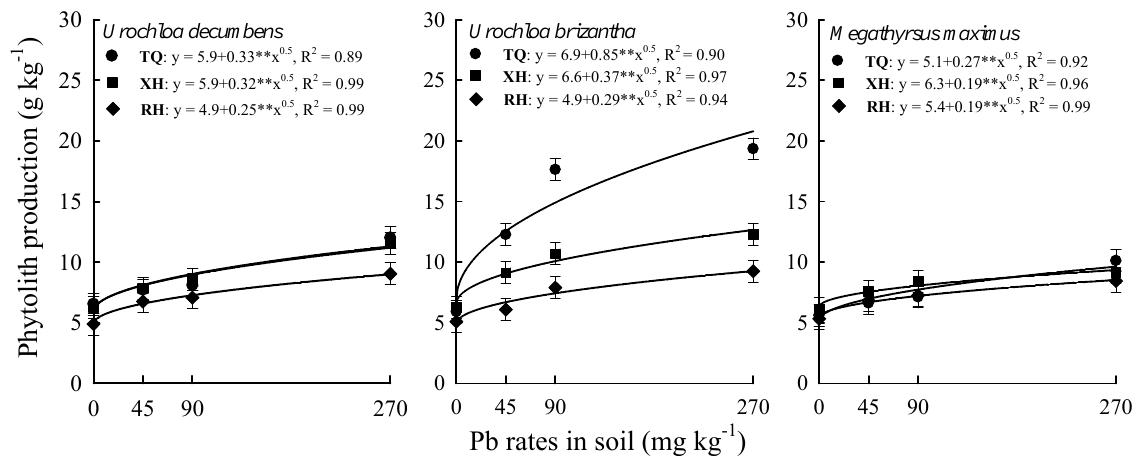
Figure 2. Phytolith production in forage grasses with increases in Pb rates within 120 days of thinning in three soils (TQ: Typic Quartzipsamment. XH: Xantic Hapludox. RH: Rhodic Hapludox) (significant at ** p = 0.01).